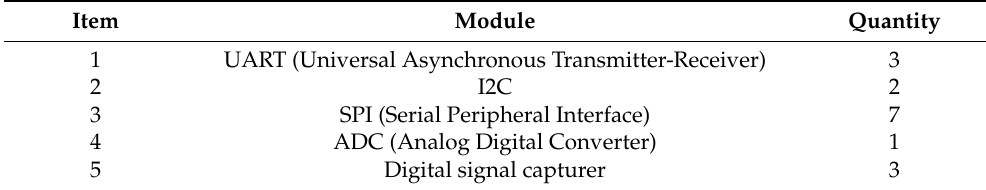
Table 3. Hardware